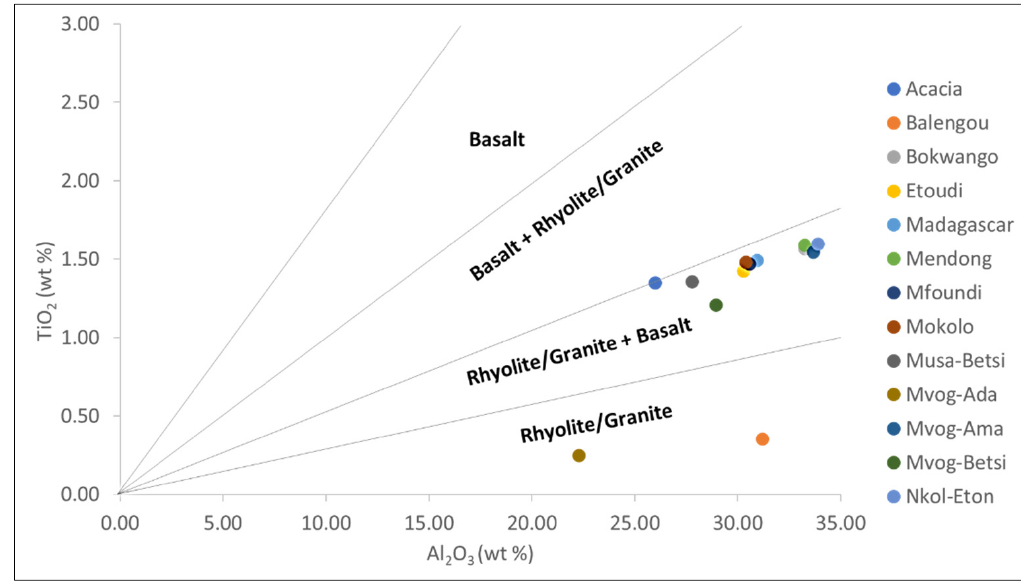
Figure 9. TiO 2 -Al 2 O 3 binary plot of bulk samples (fields from Ekosse [59]). Reprinted with permission from ref. 51213800615102. Copyright 2001 Elsevier.